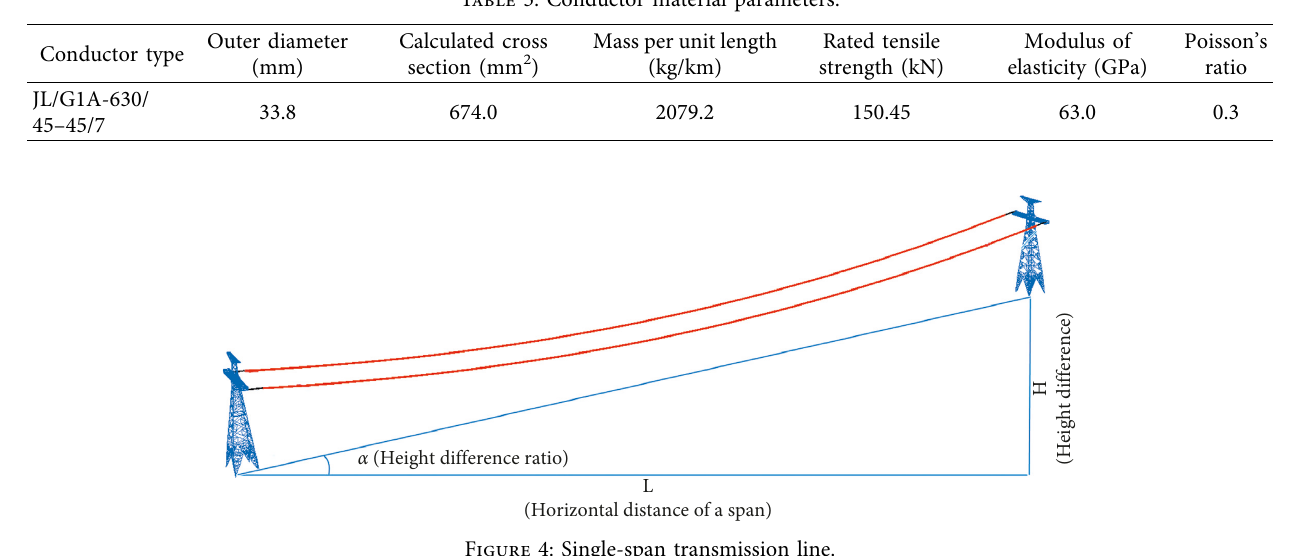
Table 5: Conductor material parameters.